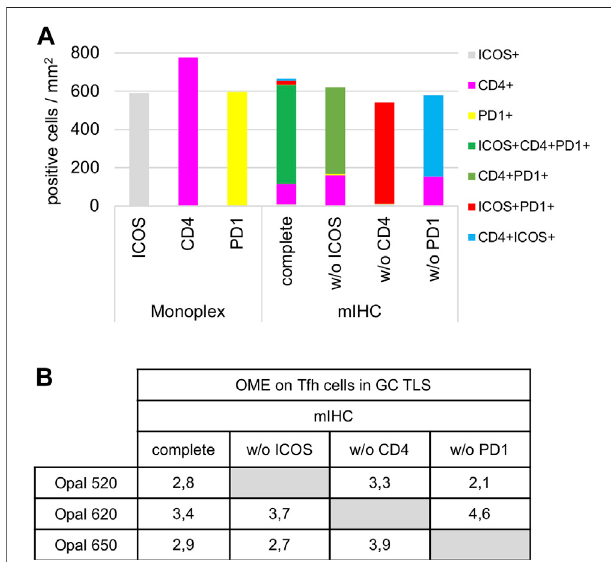
FIGURE 7 | Cell density and Opal expression quanti fi cation of drop control slides. (A) Cell density quanti fi cation of CD4 + , ICOS + , PD-1 + , and T FH subpopulations (ICOS + CD4 + PD-1 + , CD4 + PD-1 + , ICOS + PD-1 + , CD4 + ICOS + ) onmonoplexslides,themIHCslideand dropcontrolslideswithout(w/o) ICOS, CD4, or PD-1. Each condition was quanti fi ed following the work fl ow shown in Figure 4A in a TLS GC (black dotted line in Figure 6 ). (B) Quanti fi cation of520, 620, and 650 Opal mean expression (OME) on T FH cells from an mIHC slide and drop control slides without (w/o) ICOS, CD4, PD-1 staining. Each condition was quanti fi ed followed the work fl ow as described above. The slides were scanned at × 20 magni fi cation with the Vectra Polaris and the composite images were analyzed with InForm software